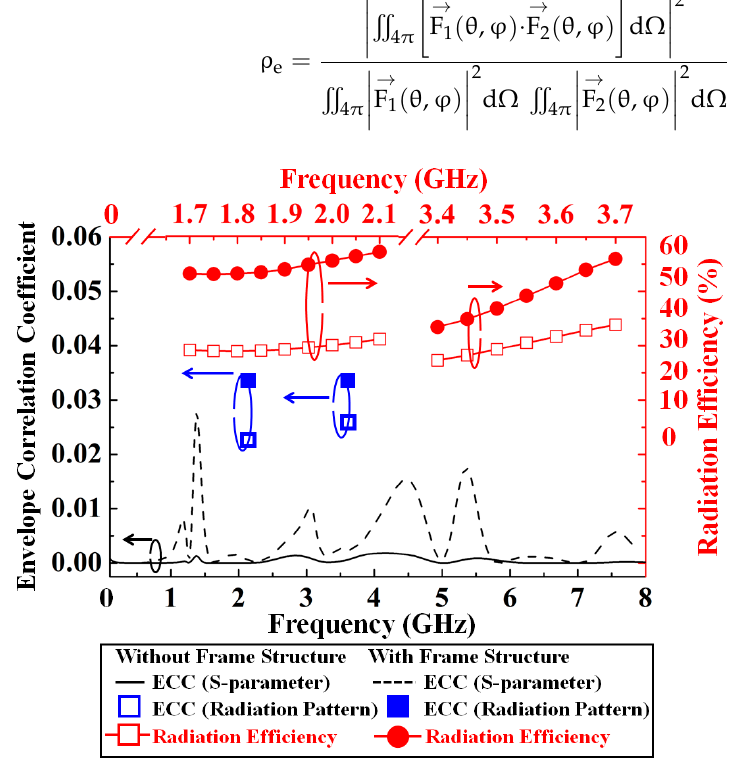
Figure 7. Measured envelope correlation coefficient (ECC) and microwave radiation efficiency of the dual-band transparent antenna with and without using the frame structure.